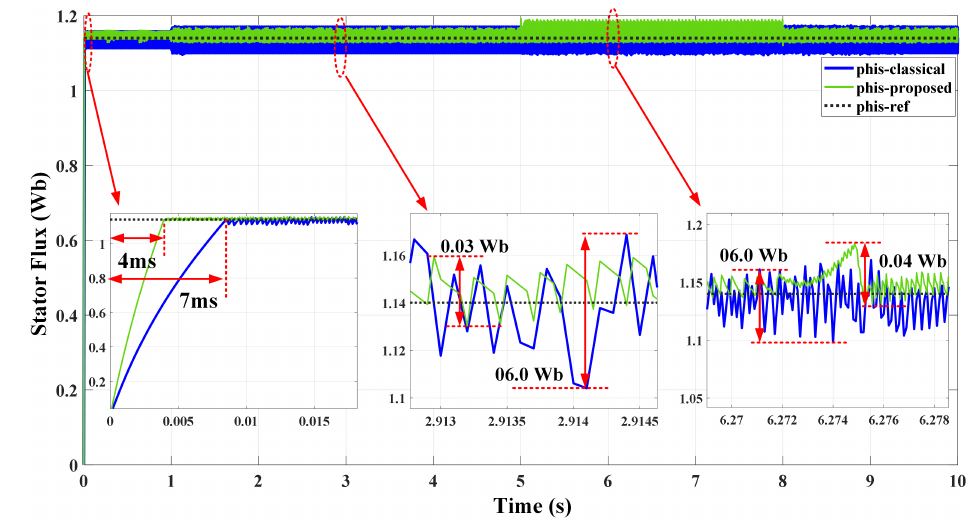
Figure 14. Stator flux response in both the classical and improved